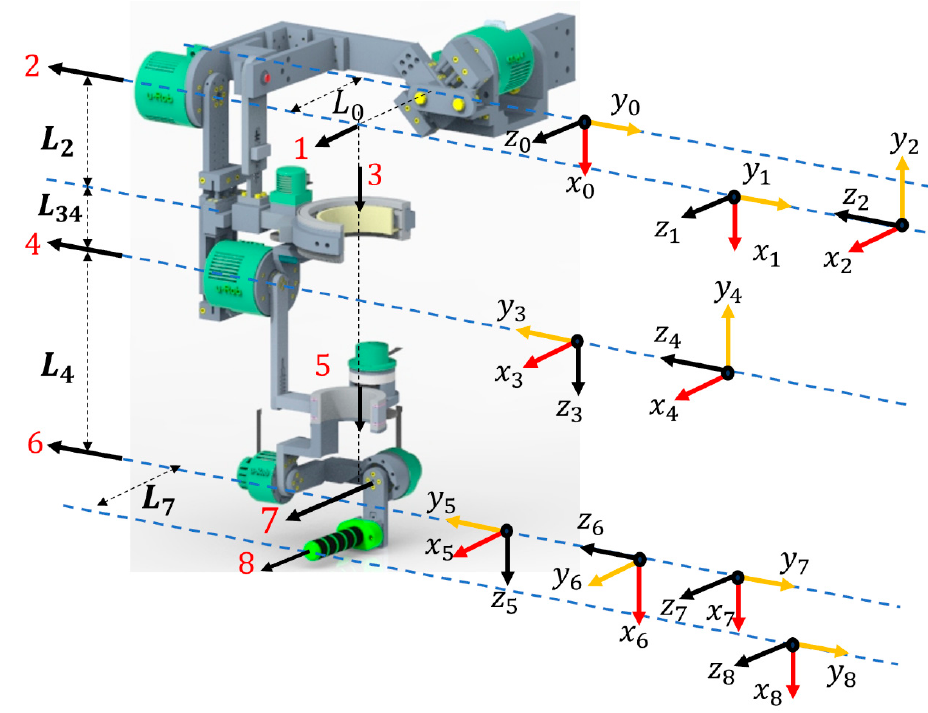
Figure 14. Link frame attachments to the proposed exoskeleton robot. Table 4. Modified Denavit–Hartenberg parameters for the proposed exoskeleton robot.